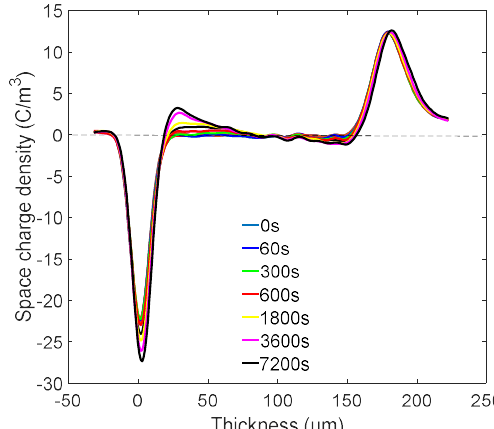
Figure 3. PEA measurement data in fresh cross-linked polyethylene (XLPE) samples at 20 kV/mm field under room temperature.